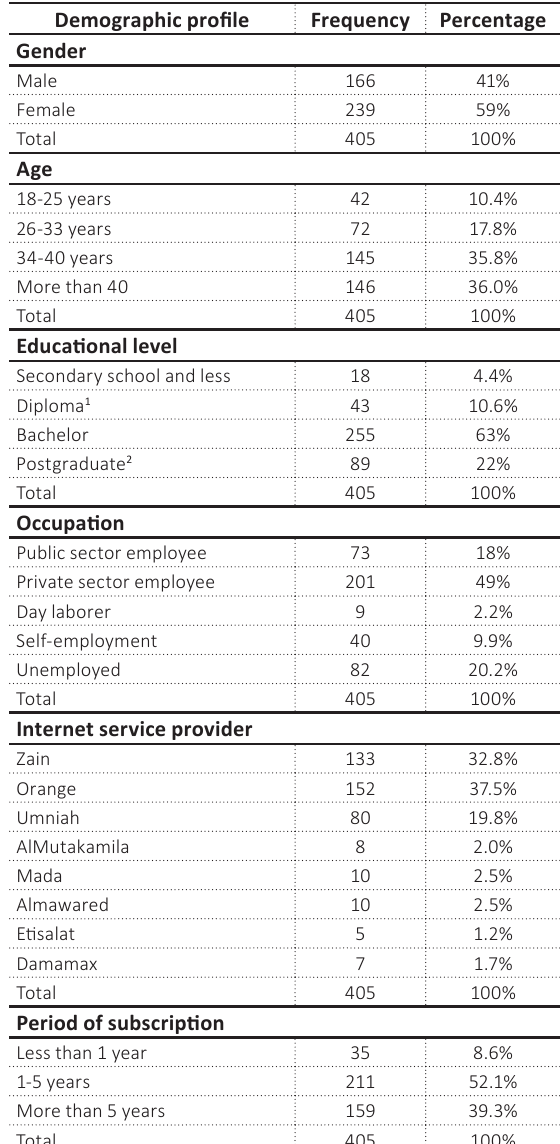
Table 1. Descriptive